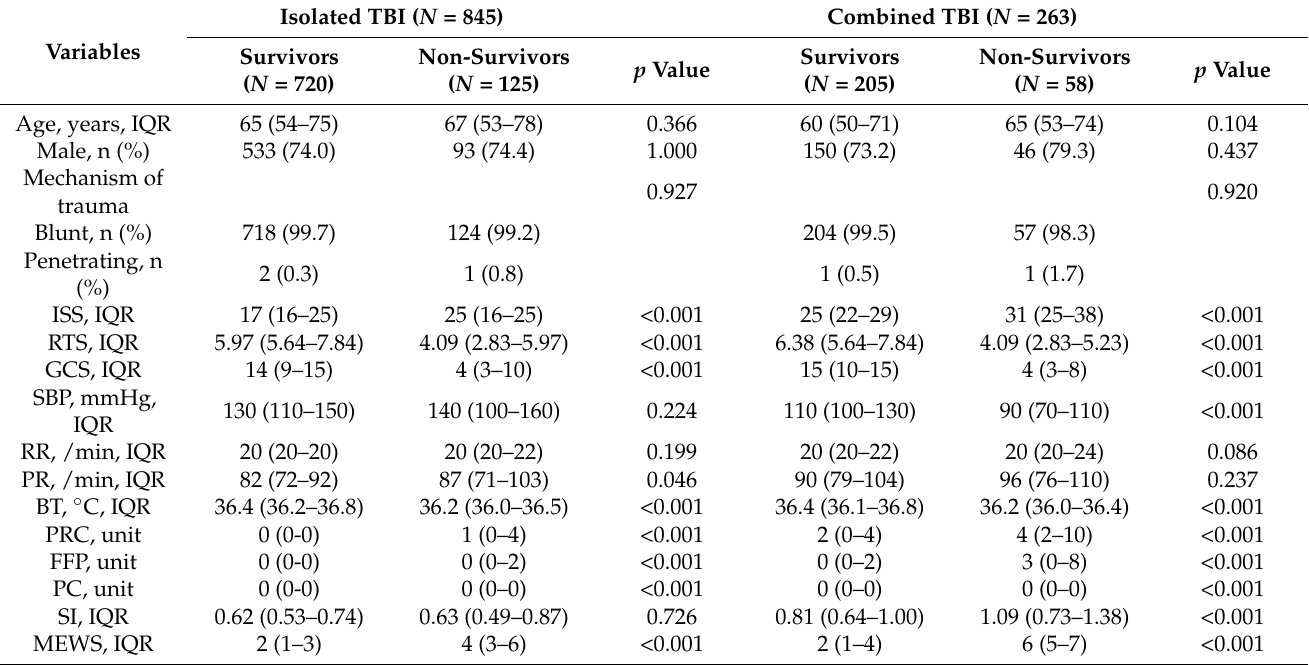
Table 4. Comparison of baseline characteristics according to in-hospital mortality in isolated TBI and combined TBI groups.